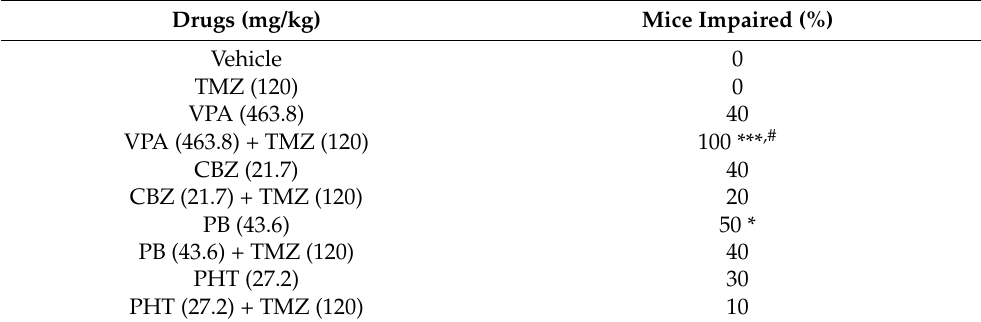
Results are presented as percentage of animals that failed to perform the chimney test. Statistical analysis of data was performed using Fisher’s exact probability test. Drug doses used in the chimney test reflect ED 50 doses of combinations of TMZ (120 mg/kg) with the antiepileptic drugs from the MES test. TMZ—trimetazidine, VPA—valproate, CBZ—carbamazepine, PB—phenobarbital, PHT—phenytoin, # p < 0.05 vs. VPA, * p < 0.05 vs. vehicle and TMZ; *** p < 0.001 vs. vehicle and TMZ.